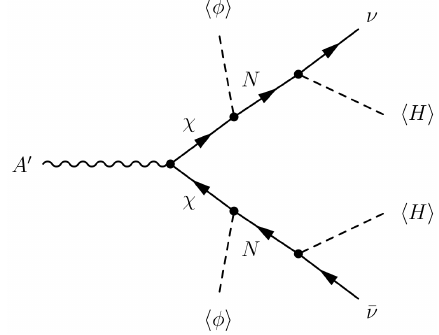
Figure 1 . The A 0 → ν ¯ ν decay at